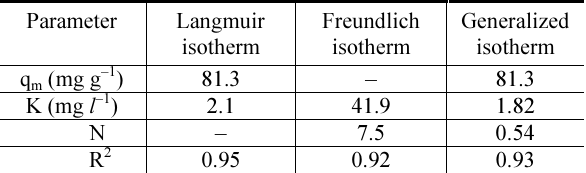
Table 1. Summary of the isotherm constants and the